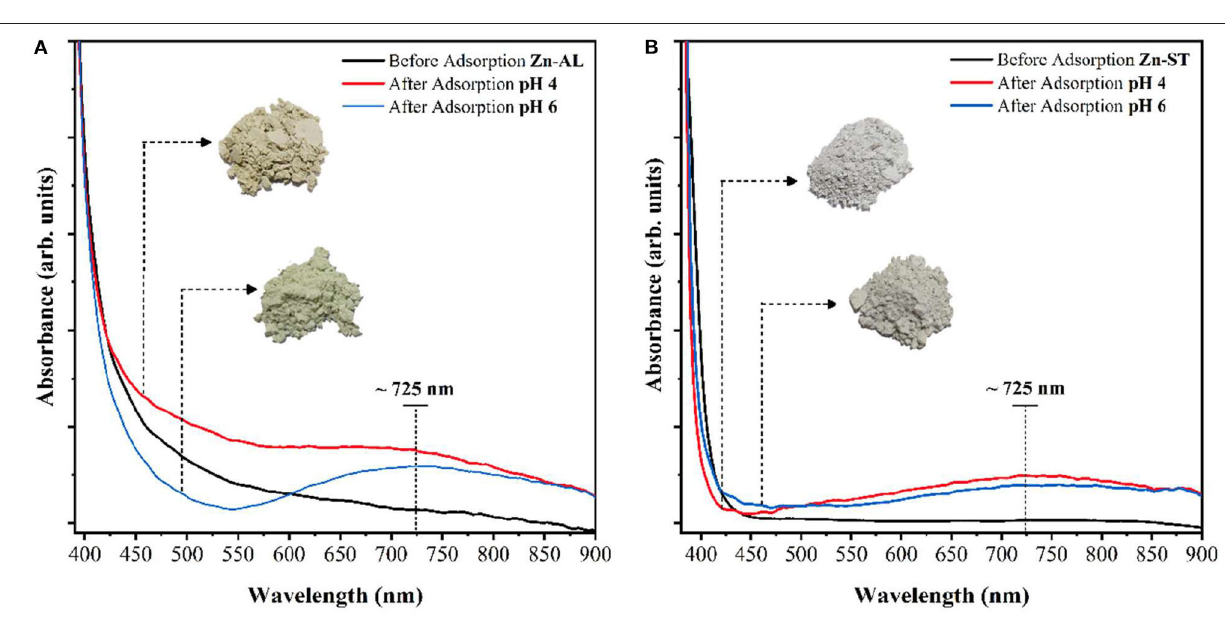
adsorption occurring at sites available on the oxide surface. While the second linear portion refers to the adsorption in the final stages of the adsorption equilibrium, where the intraparticle diffusion process begins to decrease and reach a plateau due to the low concentration of remaining Cu (II) ions or because the maximum adsorption by the adsorbate is achieved (Rafiq et al., 2014; Jaerger et al., 2015). The results of the intraparticle